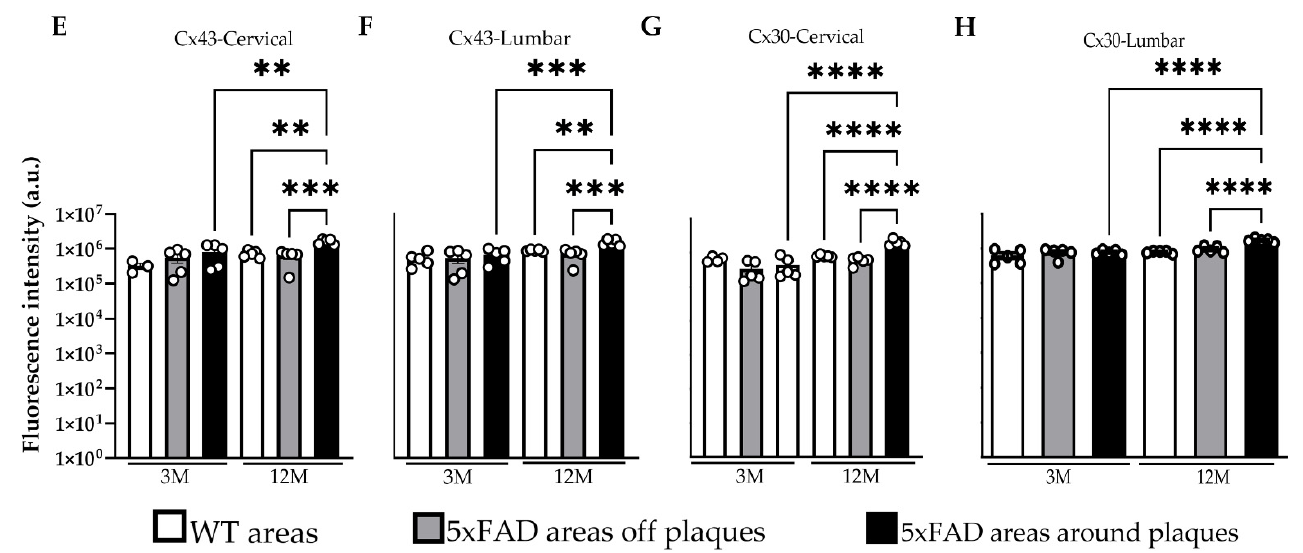
Figure 5. Increased immunoreactivity of astrocytic Cx43 and Cx30 around β -amyloid plaques within the 5xFAD spinal cord. ( A , C ) In cervical C3 and ( B , D ) lumbar L3 spinal cord sections from 5xFAD and WT mice, double immunofluorescence staining was performed with β -amyloid antibody 6E10 (green) and astrocytic Cx43 ( A , B ) or Cx30 ( C , D ) antibodies (red). In 12M 5xFAD mice, the immunoreactivity of both astrocytic connexins around the perimeter of amyloid plaques in the GM was increased, as can be observed with white arrows in the higher magnification insets highlighted in purple rectangles for cervical sections ( A , C ) and yellow rectangles ( B , D ) for lumbar sections. Quantification of the fluorescent intensity of Cx43 ( E , F ) and Cx30 ( G , H ) in GM areas around amyloid plaques, areas off plaques, and in corresponding WT areas confirmed that the immunoreactivity of Cx43 and Cx30 was significantly higher around the perimeter of A β plaques in comparison with areas off plaques in 5xFAD mice or with WT areas. Statistical analysis was performed by one-way ANOVA followed by Kruskal–Wallis multiple comparisons test ( n = 6 for all genotype and age groups). Data are presented as mean ± SD. Scale bars = 50 µm; magnified view scale bar = 10 µm ( A – D ). Significance is given as: ** p < 0.01, *** p < 0.001, **** p < 0.0001.